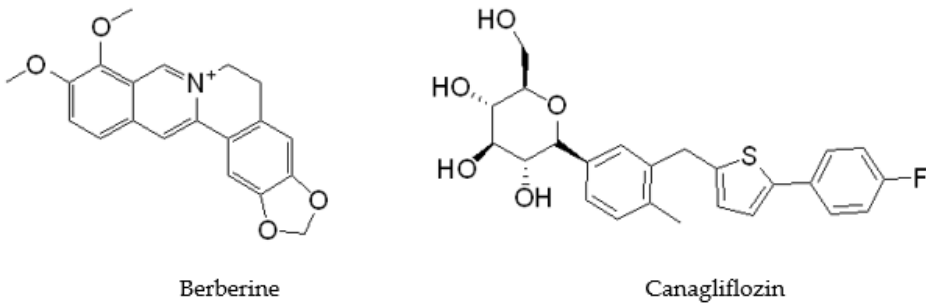
Figure 1. Chemical structure of Berberine and Canagliflozin.